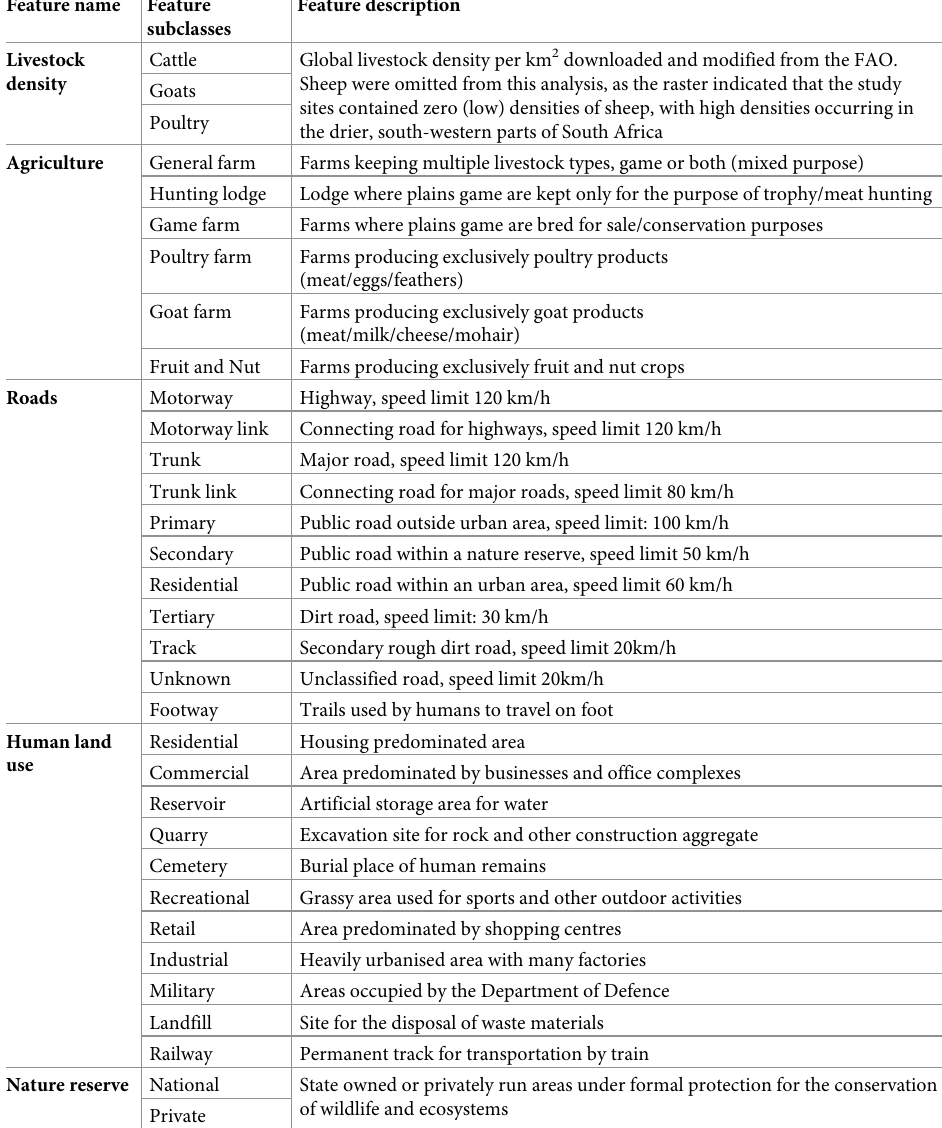
Table 1. Description and characteristics of environmental features used in resource selection function analyses for four African wild dog packs in Limpopo and Mpumalanga provinces, South Africa. Feature subclasses and descriptions were taken from pre-existing shapefile attribute tables in ArcMap, except for agricultural landscape fea- tures, which we